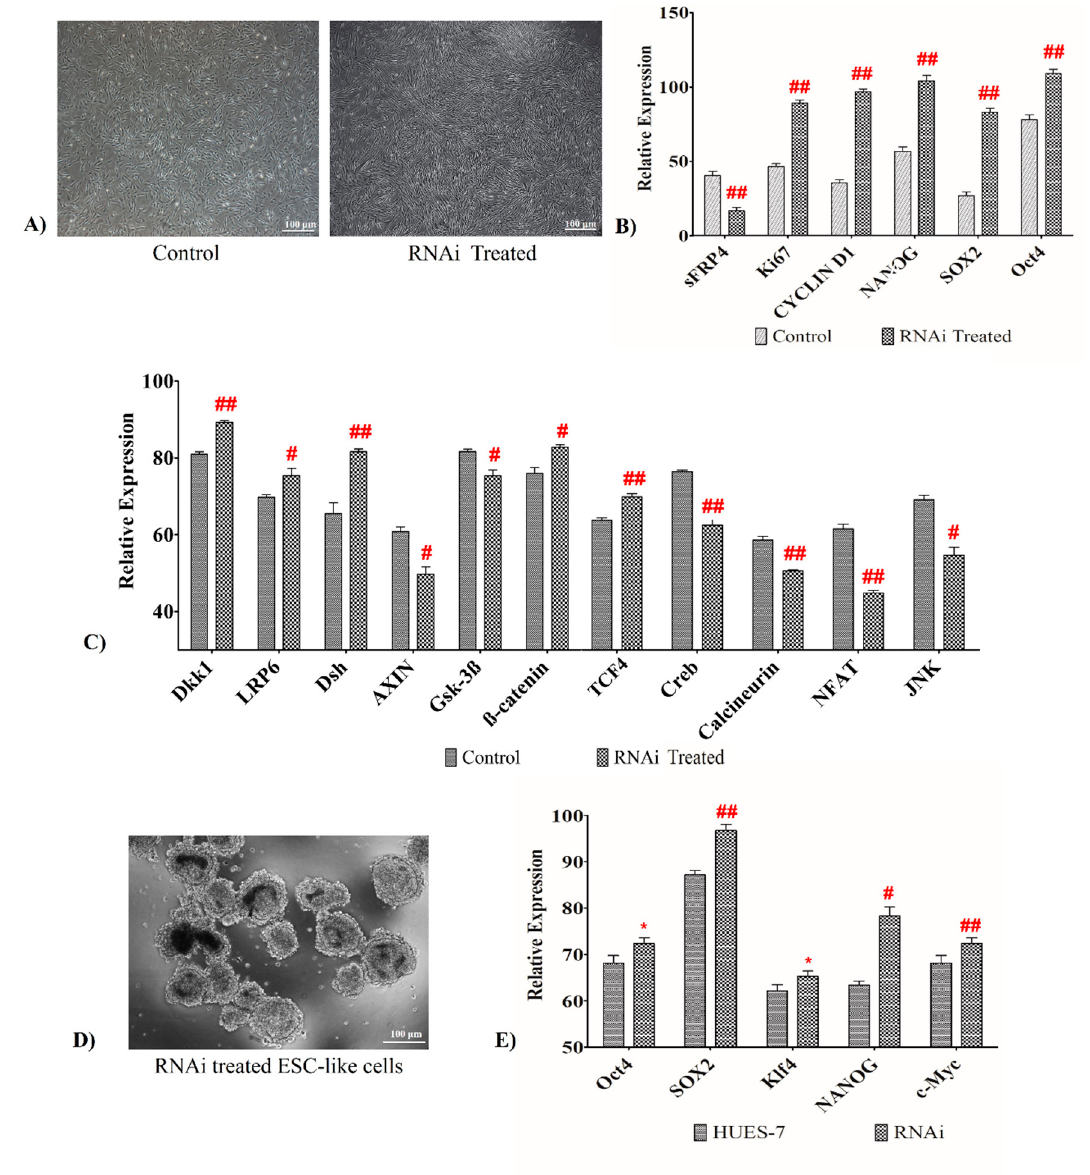
Figure 5. ( A , B ). sFRP4 RNAi treatment on WJ-MSCs displayed upregulation of pluripotent genes and increased proliferation. Photomicrograph images of WJMSCs treated with sFRP4 RNAi (scale bar = 100 µm) ( A ), Relative mRNA expression of sFRP4 , KI67 , CYCLIN D1 , NANOG , SOX2 , and OCT 4 in control and sFRP4 RNAi treated WJMSCs ( B ). Figure 5 ( C ) Gene expression analyses of Wnt specific genes in control and RNAi treated WJMSCs by qRT-PCR. An upregulation of Wnt canonical and downregulation of Wnt non-canonical genes was seen in sFRP4 RNAi. Figure 5 ( D , E ) Conversion of sFRP4 RNAi-treated WJMSCs into ESC-like cells and upregulation of pluripotent genes. Photomicrograph images of sFRP4 RNAi-treated WJMSC-derived ESC-like cells (scale bar = 100 µm) ( D ), Gene expression analysis of pluripotent markers for embryonic stem cell line HUES-7 and RNAi-treated WJMSC-derived ESC-like cells showed upregulation of pluripotent markers ( E ). Results are mean ± SD of three independent experiments performed in triplicates (* p value < 0.05, # p value < 0.01, ## p value < 0.001).